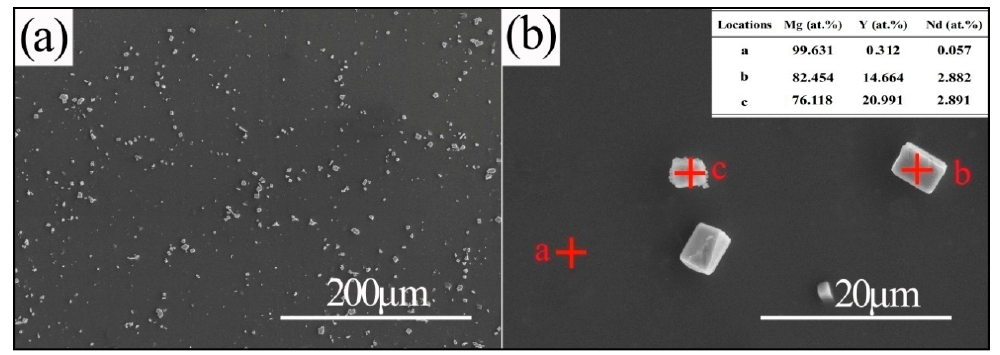
Figure 5. Amplifying SEM images and EDS results of Mg-7Y-1.5Ndafter T6-cryogenic quenching.